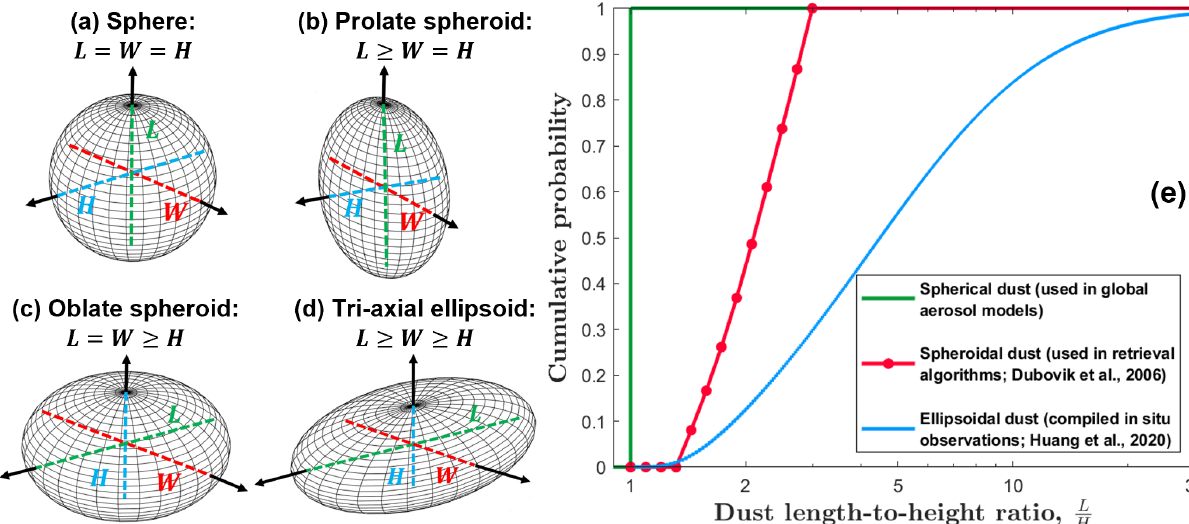
Figure 1. Global aerosol models and remote sensing retrieval algorithms use inconsistent and inaccurate dust shape quantifications. Most aerosol models approximate dust as (a) spherical particles, whose three perpendicular axes (i.e., dust length L , width W , and height H ) are equal (Gliß et al., 2021). Most retrieval algorithms approximate dust as spheroidal particles with an equal presence of (b) prolate spheroid and (c) oblate spheroid at the same length-to-height ratio (Dubovik et al., 2006). A compilation of dust shape measurements found that the three perpendicular axes differ substantially for most dust particles and thus that approximating dust as triaxial ellipsoids (d) is more realistic (Huang et al., 2020). Panel (e) compares the cumulative probability distributions of the dust length-to-height ratio used in most aerosol models (in green) and retrieval algorithms (in red) and those obtained from a measurement compilation (in blue; see Sect. 2.2). The red dots in panel (e) denote the 13 shape bins used in the AERONET retrieval algorithm (Dubovik et al., 2006; Giles et al., 2019). AERONET chose its dust shape distribution as the one that resulted in the best fit between the simulated scattering matrix and laboratory-measured scattering matrix of a sample of crushed feldspar rocks (see Sect. 2.3). However, this shape distribution conflicts with measurements of dust shape and is substantially less aspherical than natural dust aerosols. This optimized dust shape distribution is widely adopted in most other retrieval algorithms (e.g., MODIS Deep Blue; Hsu et al., 2019). As such, aerosol models and retrieval algorithms substantially underestimate the dust length-to-height ratio relative to